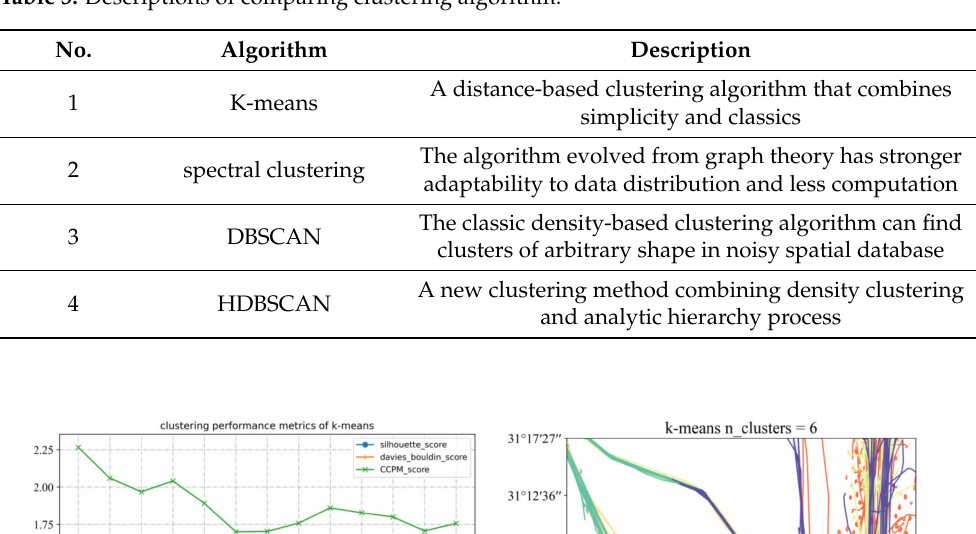
Table 3. Descriptions of comparing clustering algorithm.